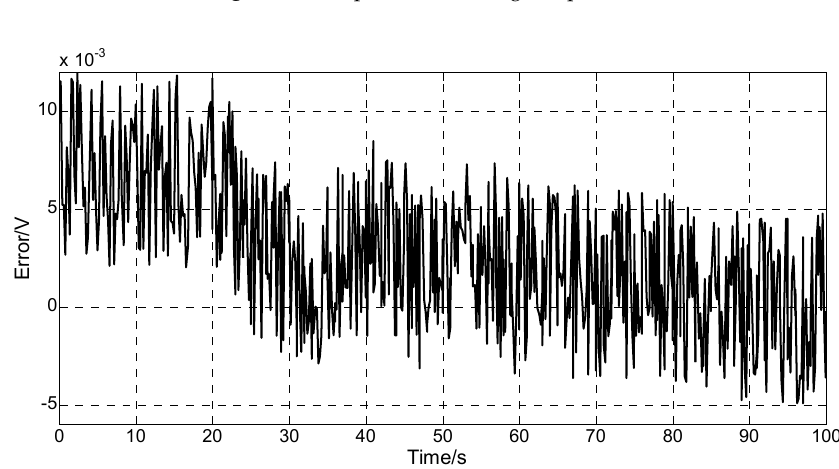
Energies 2016 , 9 , 100